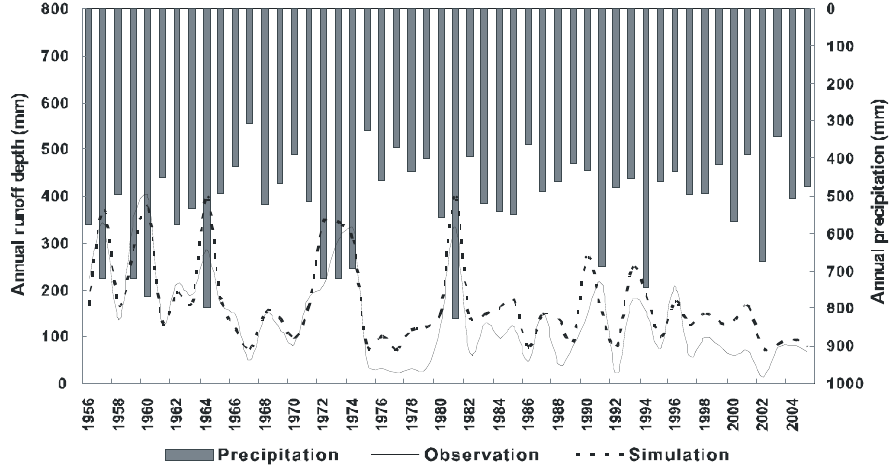
Figure 6. Annual precipitation and simulated and observed runoff depth using the IHACRES model in the upper Naoli River watershed, during 1956–2005.